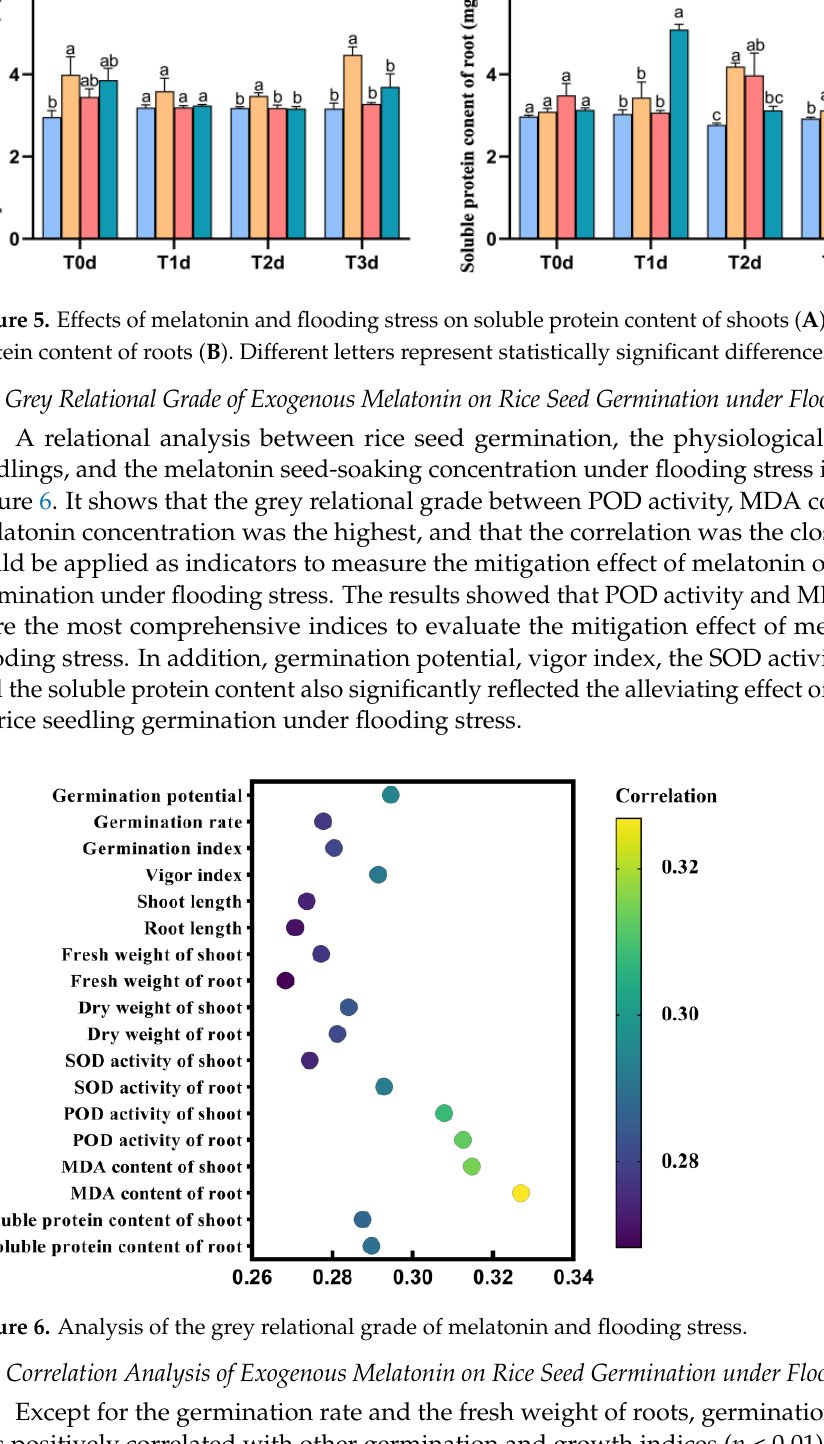
Figure 5. Effects of melatonin and flooding stress on soluble protein content of shoots ( A ) and soluble protein content of roots ( B ). Different letters represent statistically significant differences ( p < 0.05).